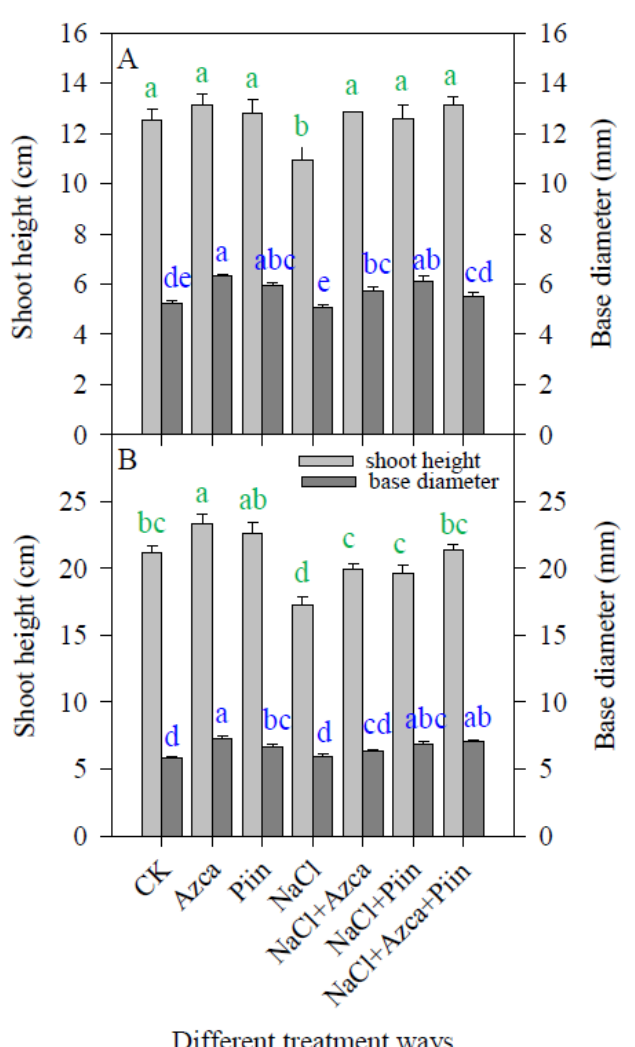
Figure 2. Changes in height and stem diameters of tomato plants under different treatments. ( A ): a week after salt treatment; and ( B ): two weeks after salt treatment. Results were shown as mean ± SE ( n = 3). Green and blue lowercases indicate statistical differences in shoot height and base diameters, respectively. The means with identical lowercase indicate insignificant differences ( p > 0.05).